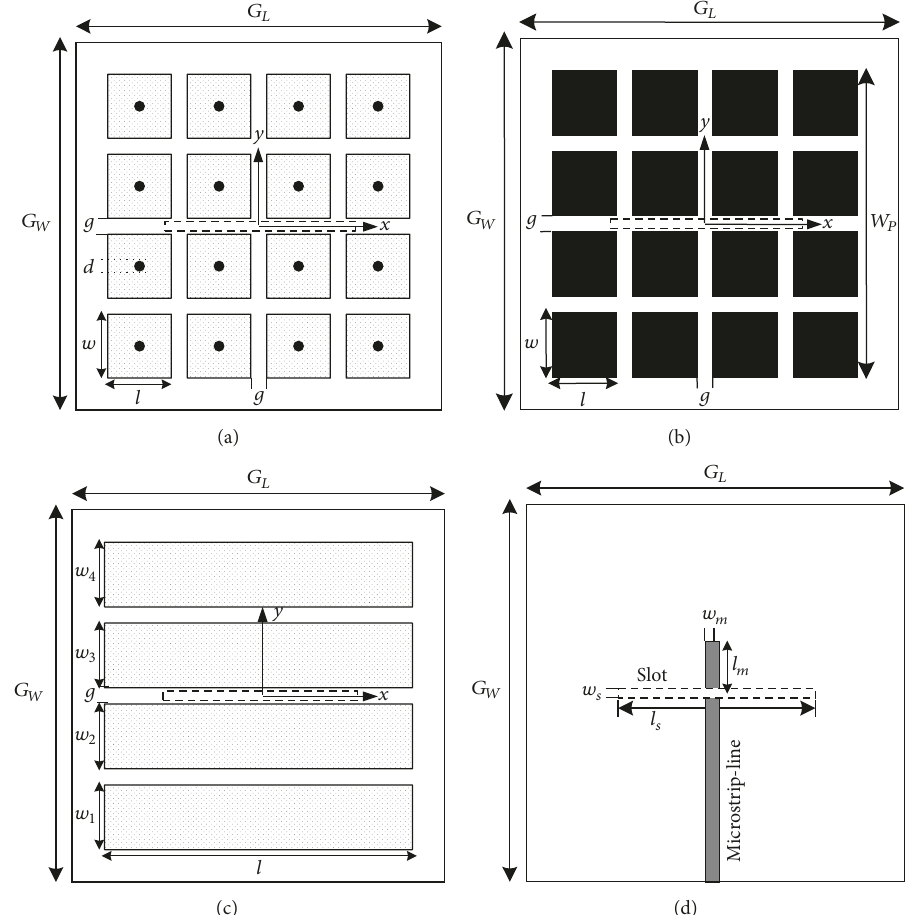
Figure 1: Three slot-fed antennas with different MPs. (a) MP I composed of 4×4 rectangular patch cells which are shorted to the ground plane with vias. (b) MP II composed of 4 × 4 rectangular patch cells. (c) MP III composed of 1 × 4 rectangular patch cells. (d) Microstrip-coupled